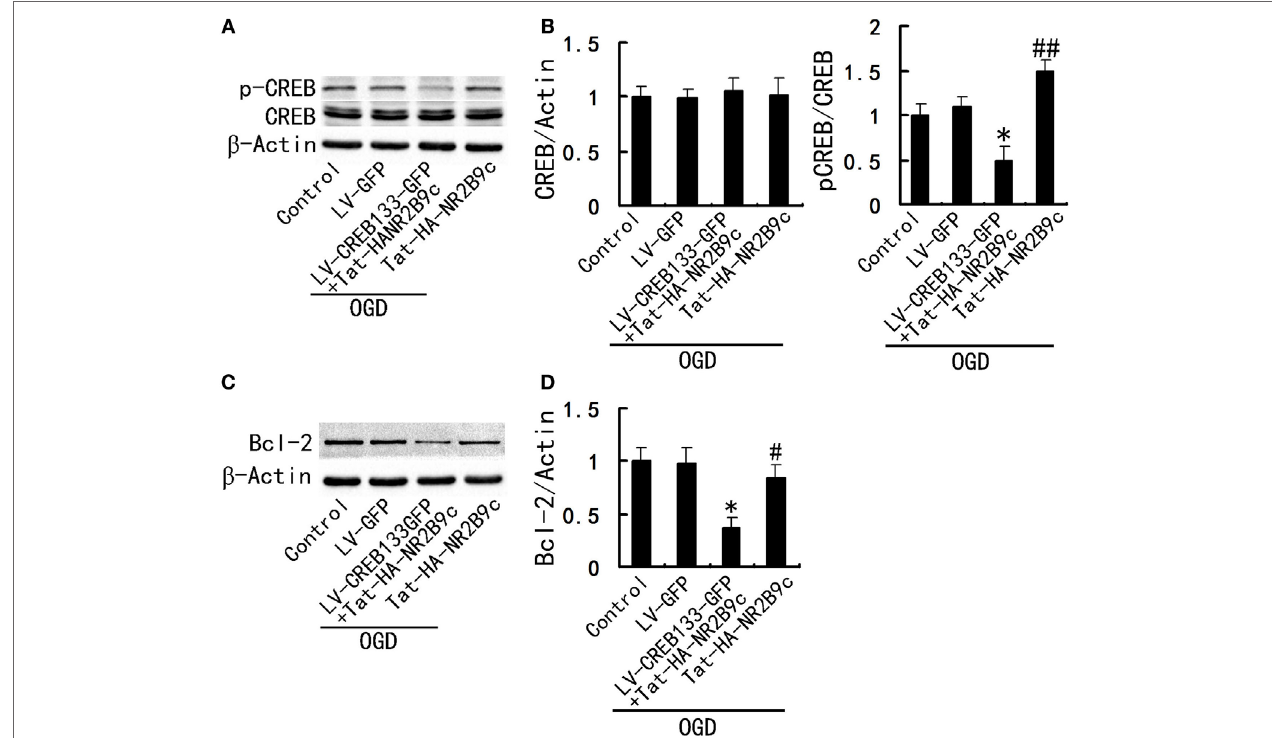
FigUre 4 | Inhibition of CREB activity abolish the regulation of Tat-HA-NR2B9c on B-cell lymphoma-2 (Bcl-2). (a) Immunoblots image showing phospho-CREB (p-CREB) and CREB in primary hippocampal neurons cultured in the plain medium (control); LV-GFP infected neurons; and neurons infected with LV-CREB133-GFP or not, exposed to oxygen glucose deprivation (OGD) and then treated with 250 nM of Tat-HA-NR2B9c, respectively. (B) Statistical graph from data in (a) , n = 5. (c) Immunoblots image showing Bcl-2 in primary hippocampal neurons cultured in the plain medium (control); LV-GPF infected neurons; and neurons infected with LV-CREB133-GFP or not, exposed to OGD and then treated with 250 nM of Tat-HA-NR2B9c, respectively. (D) Statistical graph from data in (c) , n = 5. Data are mean ± SEM (* P < 0.05 vs sham; # P < 0.05 and ## P < 0.01 vs